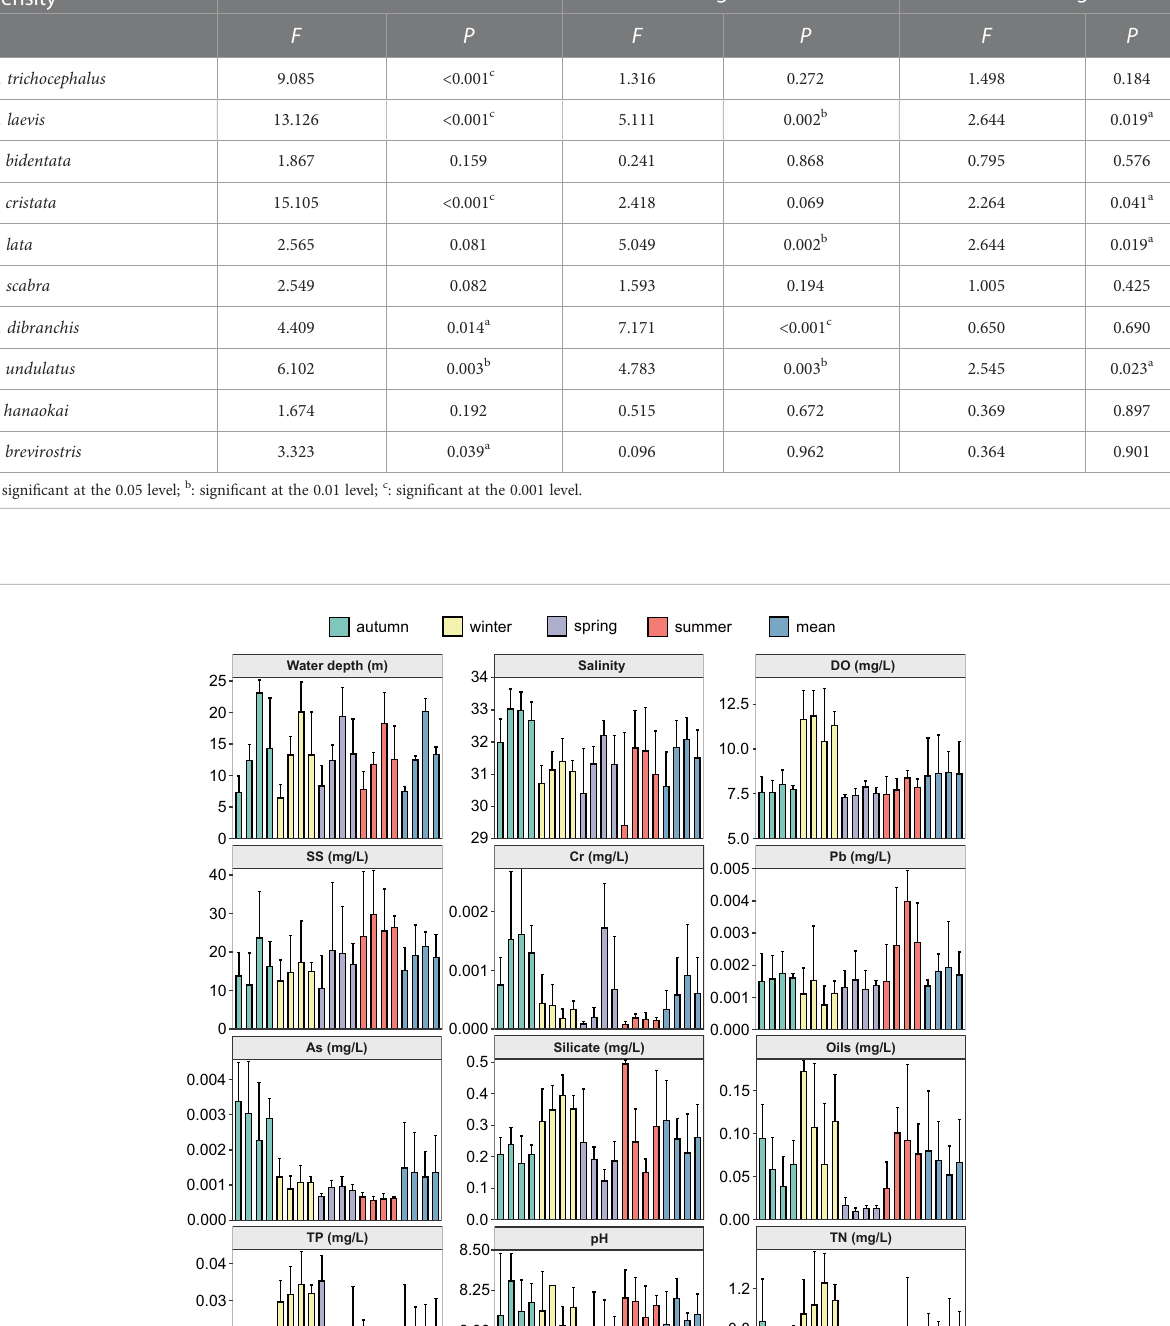
TABLE 2 The F and P values between seasons and regions for biomass of ten benthic macrofauna species in subtidal zone near the Daya Bay Nuclear Power Plant. Density Season Region Season ×